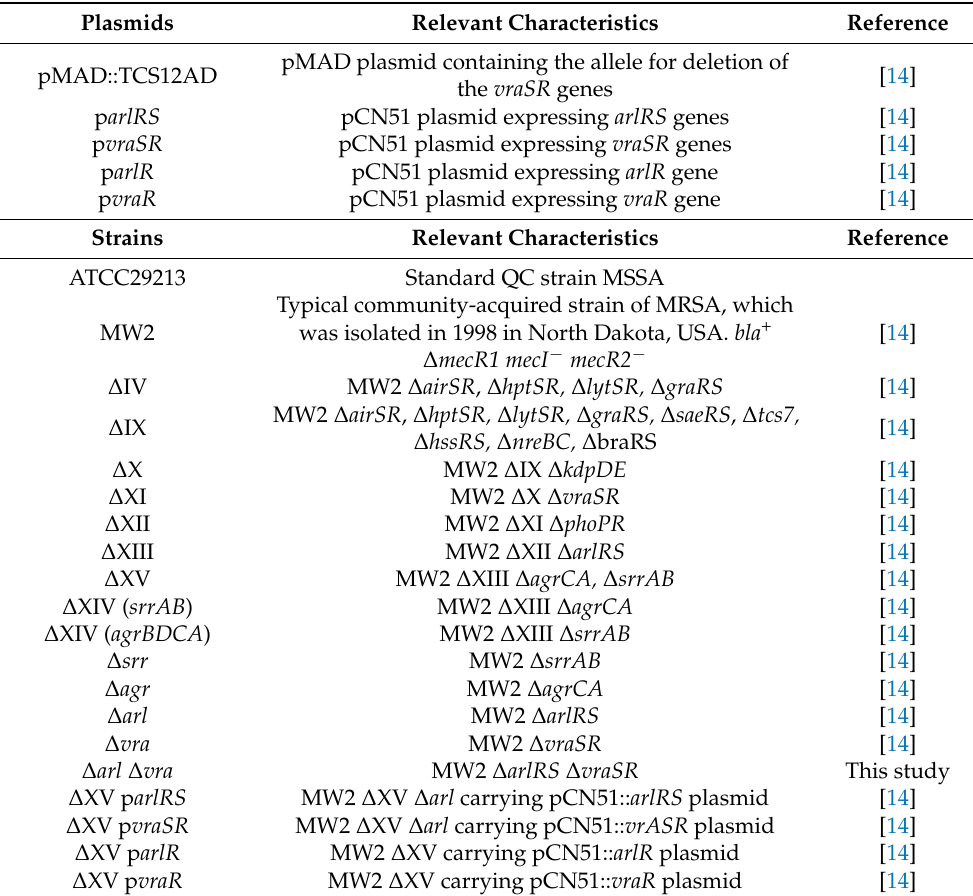
Table 2. Plasmids and strains were used in this